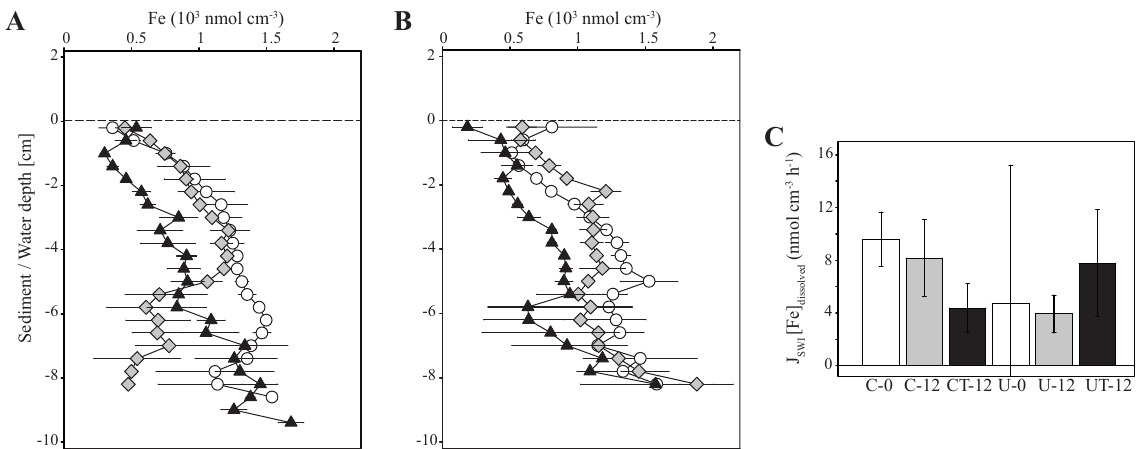
Figure 3. Dissolved total Fe concentration profiles in uncontaminated ( A ) and U-spiked sediment ( B ) in the different treatments: at initial conditions [C-0] and [U-0] (- (cid:13) -), and after 12 days without [U-12] ( ♦ ) or with [UT-12] ( N ) T. tubifex worms in the sediment. The bar chart ( C ) indicates the corresponding integrated outward diffusive fluxes at the sediment–water interface estimated using PROFILE software. Means ± SD ( N = 3). No significant difference was detected between treatments.